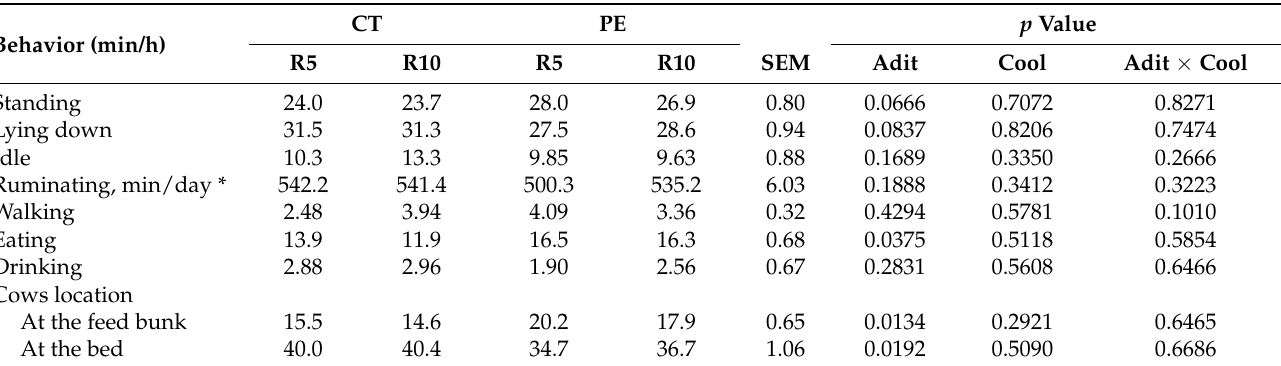
Table 5. Effects of different cooling regimens and the use or absence of PE on the behavior of lactating Holstein cows ( n =